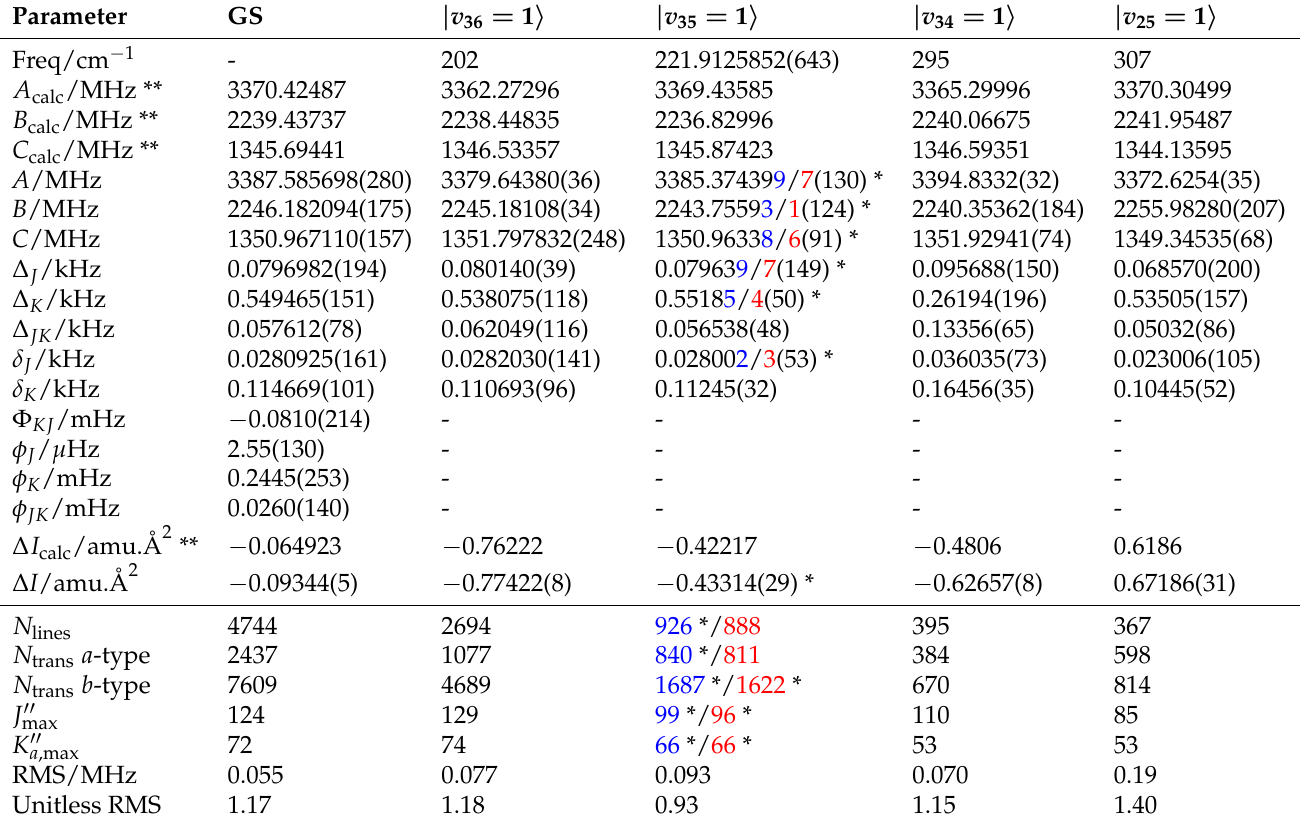
Table 5. The spectroscopic constants and fit results of the mm-wave spectrum of catechol in the GS and in the lowest frequency vibrationally ES. For the rotational constants and the inertial defects ∆ I = h fitted values are compared to the calculated values. In the lower part of the table, the number of measured lines N lines , the number of fitted transitions N trans , the maximum J , and K a values and the RMS highlighting the quality of the fit are